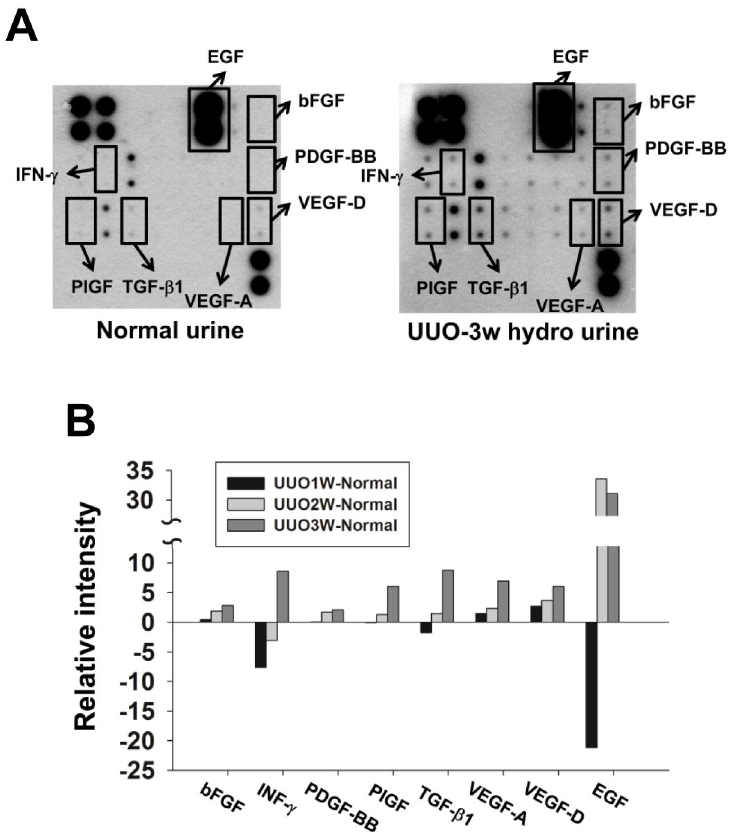
Figure 7. The expression of angiogenetic growth factors and cytokines in the hydronephrotic urine after UUO were higher than those in normal urine. In Human Angiogenesis Antibody Array analysis, the expressions of several growth factors were increased in the hydronephrotic urine from kidneys subjected to unilateral ureteral obstruction. (A) The Human Angiogenesis Antibody Array membrane was incubated with normal rat urine and hydronephrotic urine after 3 weeks UUO for 24 hrs. (B) The expression of bFGF, IFN-γ, PDGF-BB, PIGF, TGF-β, VEGF-A, VEGF-D and EGF in hydronephrotic urine were higher than those in normal urine. The relative intensity indicates the increase and decrease of the intensity of growth factors in hydronephrotic urine minus the intensity of growth factors in normal